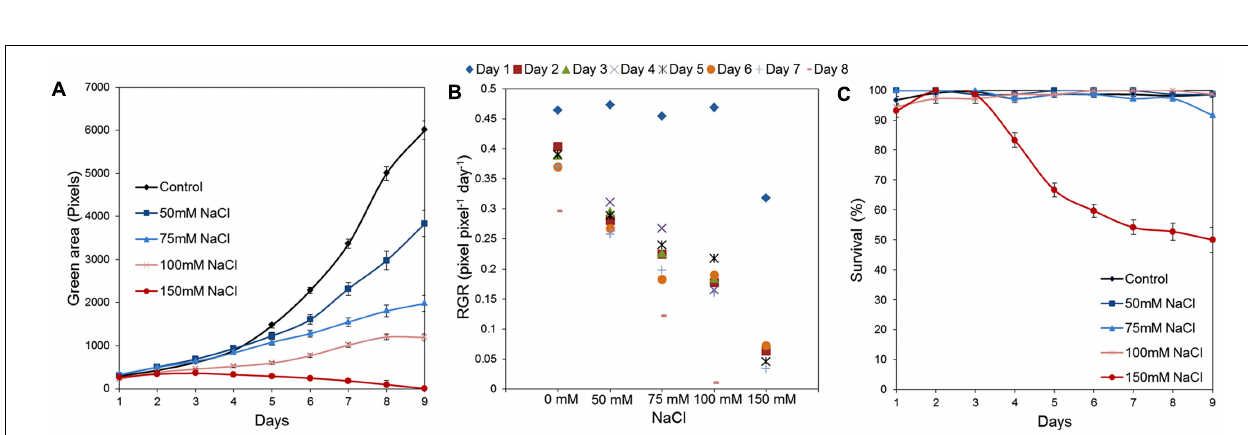
FIGURE 9 | Variation among replicates in Arabidopsis rosette growth under salt-stress. Box plots representing the green area (pixels) of 4 DAG Arabidopsis seedlings grown in 24-well plates with 1 × MS medium and different NaCl concentrations for 9 days. Statistical analysis was performed using Kruskal–Wallis’ test. ns, non-significant.